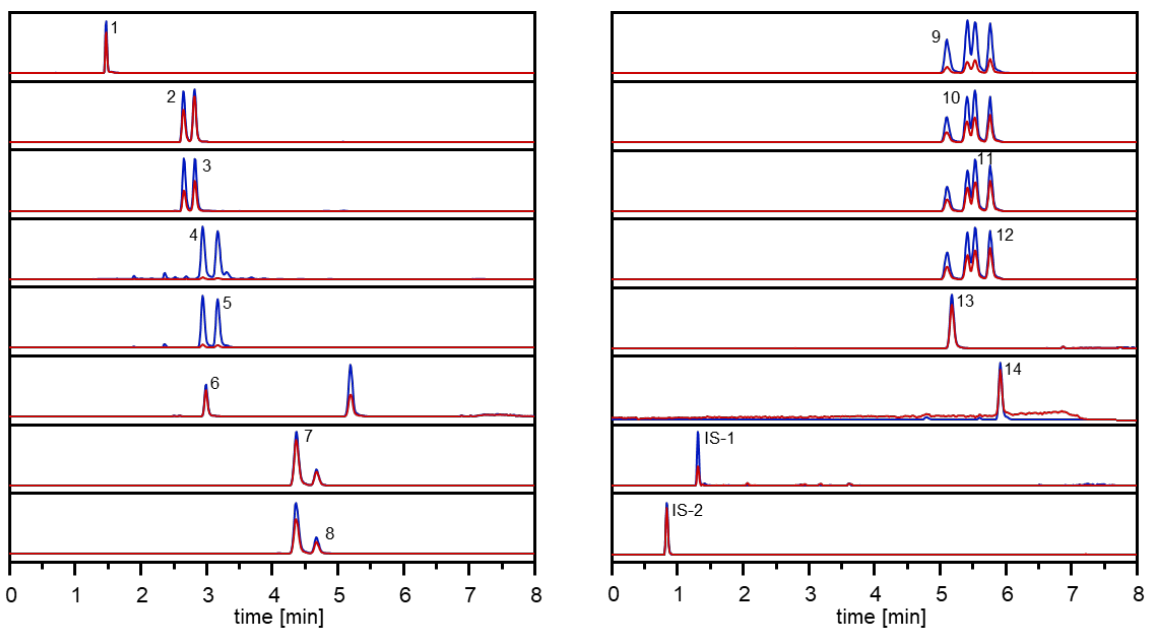
Figure 3. UHPLC-MS/MS analysis of compounds 1 – 14 in carrots.